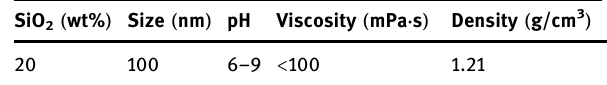
Table 4: Properties of NS powder